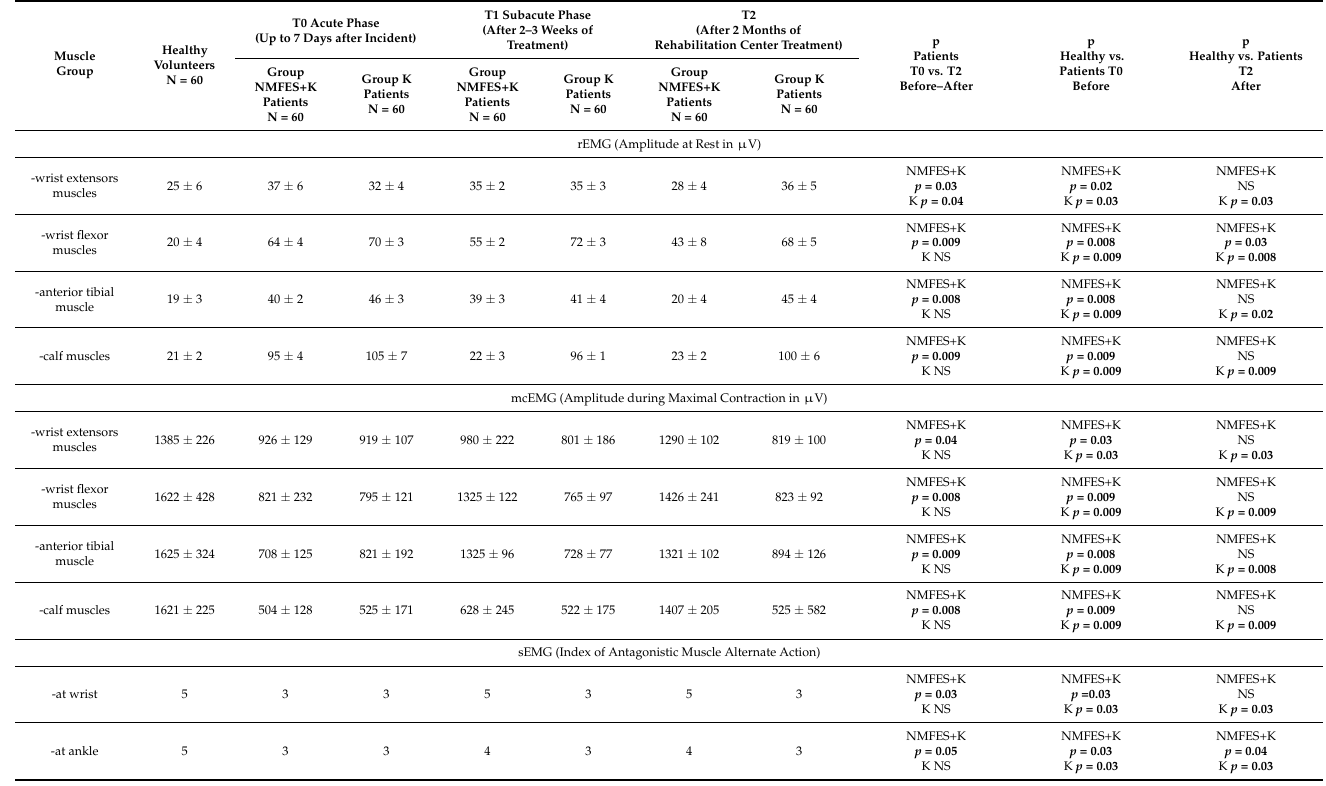
Table 3. Comparison of results from electromyographical recordings in the two groups of patients and the healthy subjects.